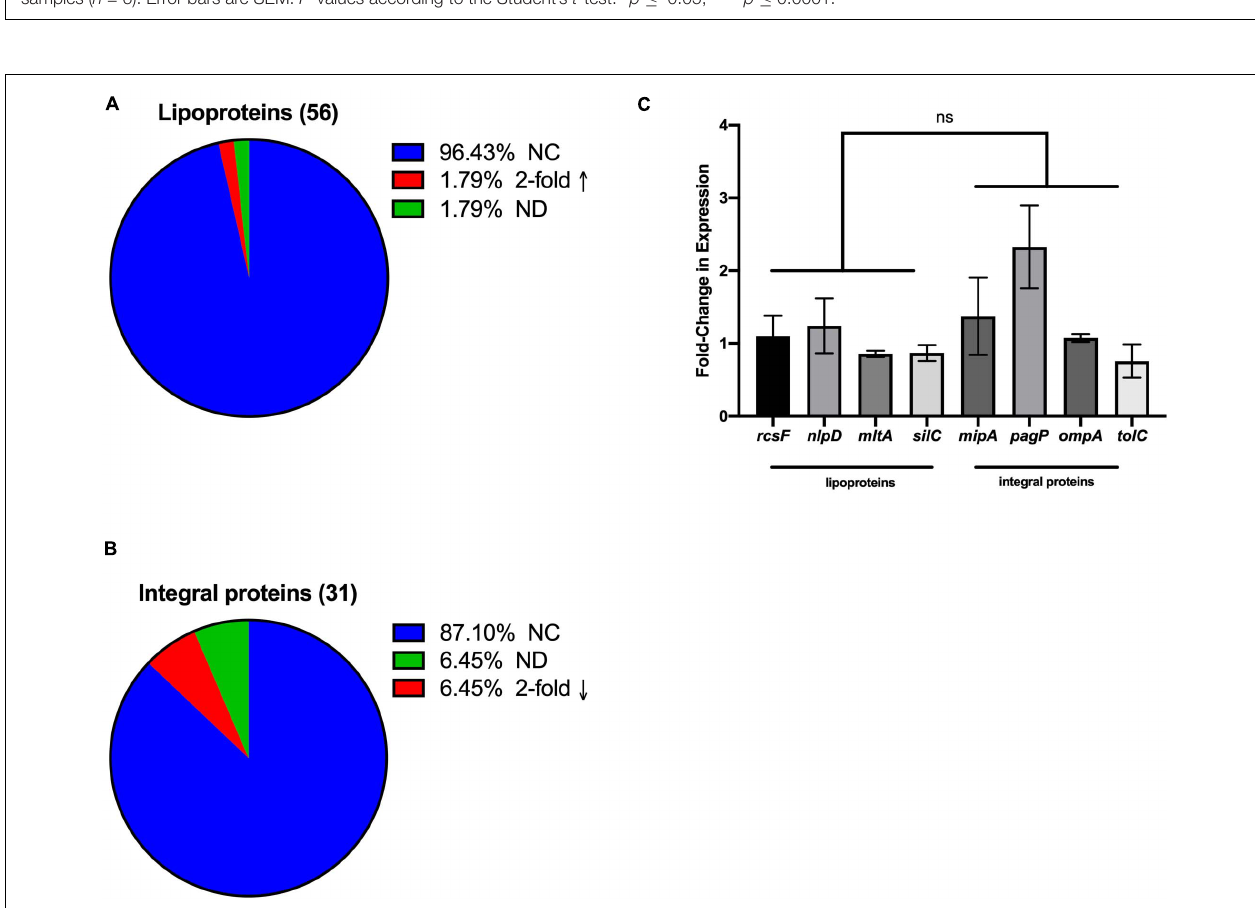
FIGURE 3 | Selective OMV packaging is not a direct reflection of expression levels for the different classes of OMV cargo. (A,B) Changes of a twofold increase or decrease from database mining of GEO profile GSE4735 for gene expression after shift from anaerobic to aerobic conditions. NC, no change; 2-fold ↑ , = at least twofold increased expression; 2-fold ↓ , = at least twofold decreased expression; ND, not in database. (C) Fold change in expression was measured by qRT-PCR after 3 h H 2 O 2 treatment compared to untreated controls for randomly selected genes encoding OM lipoproteins or integral OM proteins in ETEC. Error bars are SEM; ns, not